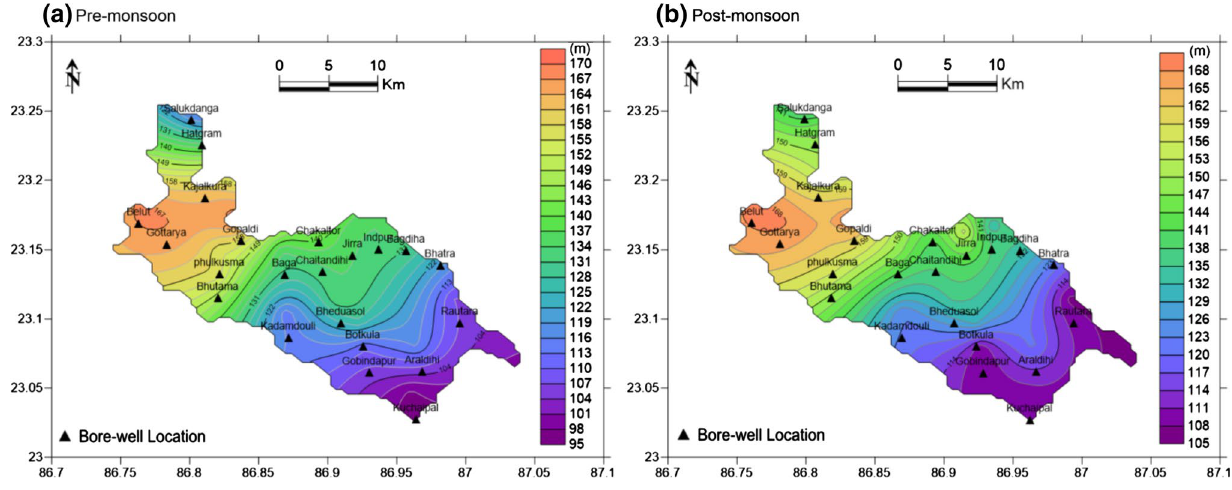
Fig. 3 Spatial fluctuation of groundwater table head (MASL) for a PrM; b PoM